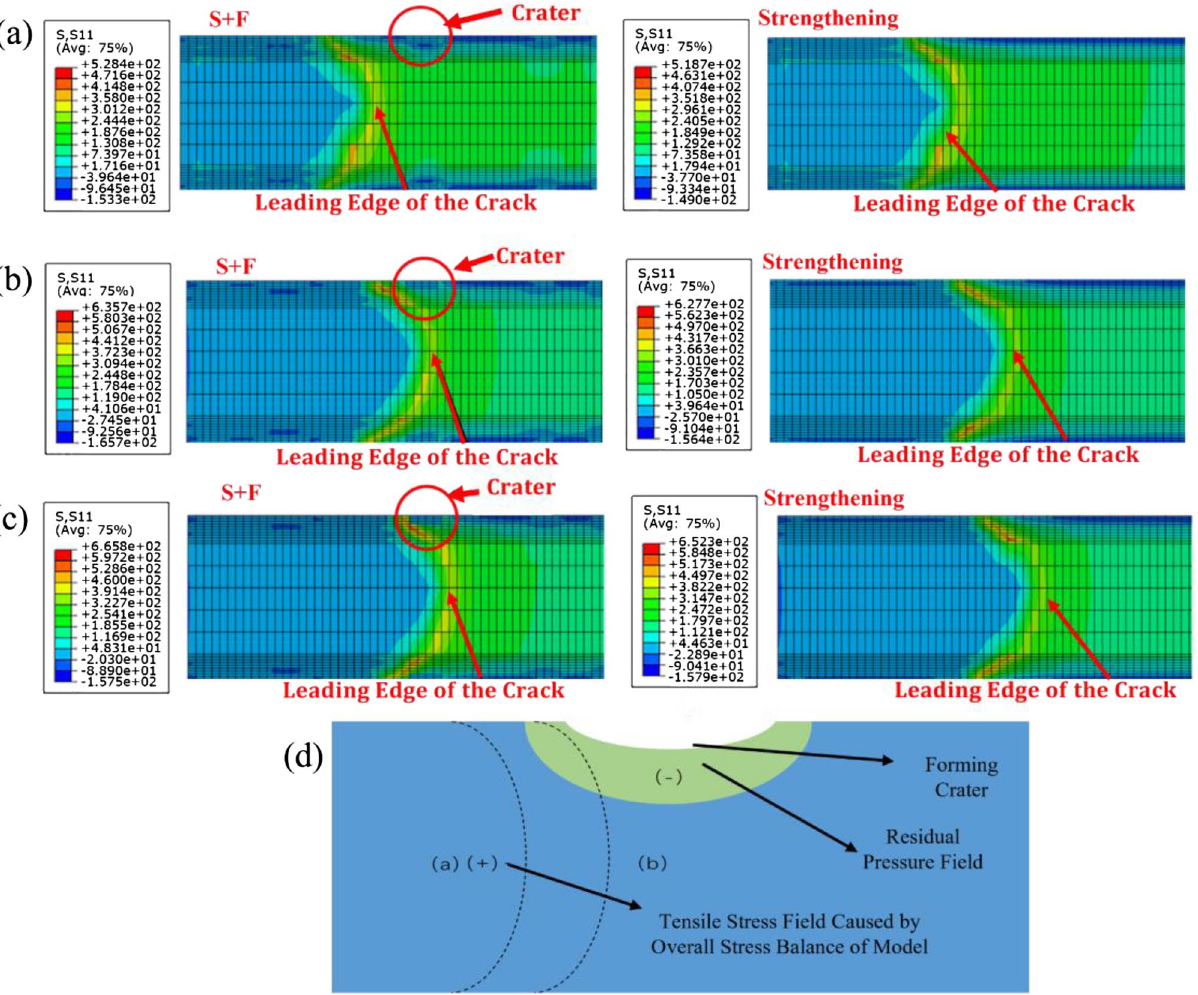
Figure 5. Tip stresses in different relative positions: ( a ) Before residual stress-affected area; ( b ) Enters residual stress-affected area; ( c ) Enters crater geometric boundary area; ( d ) Mechanism of crack growth